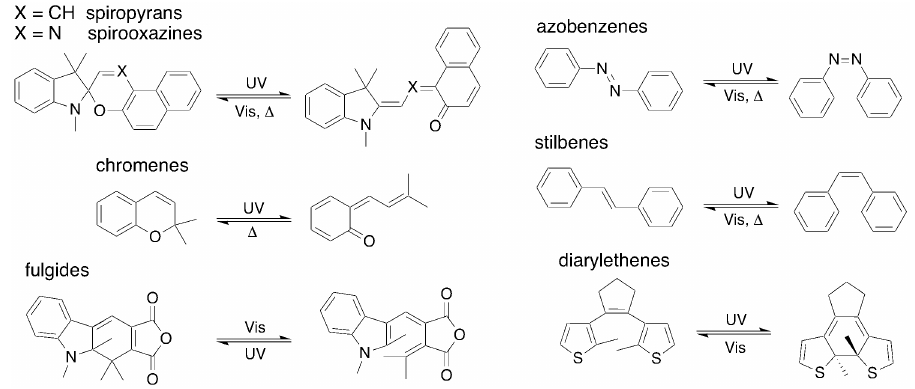
Figure 1. Classes of organic photochromic compounds .